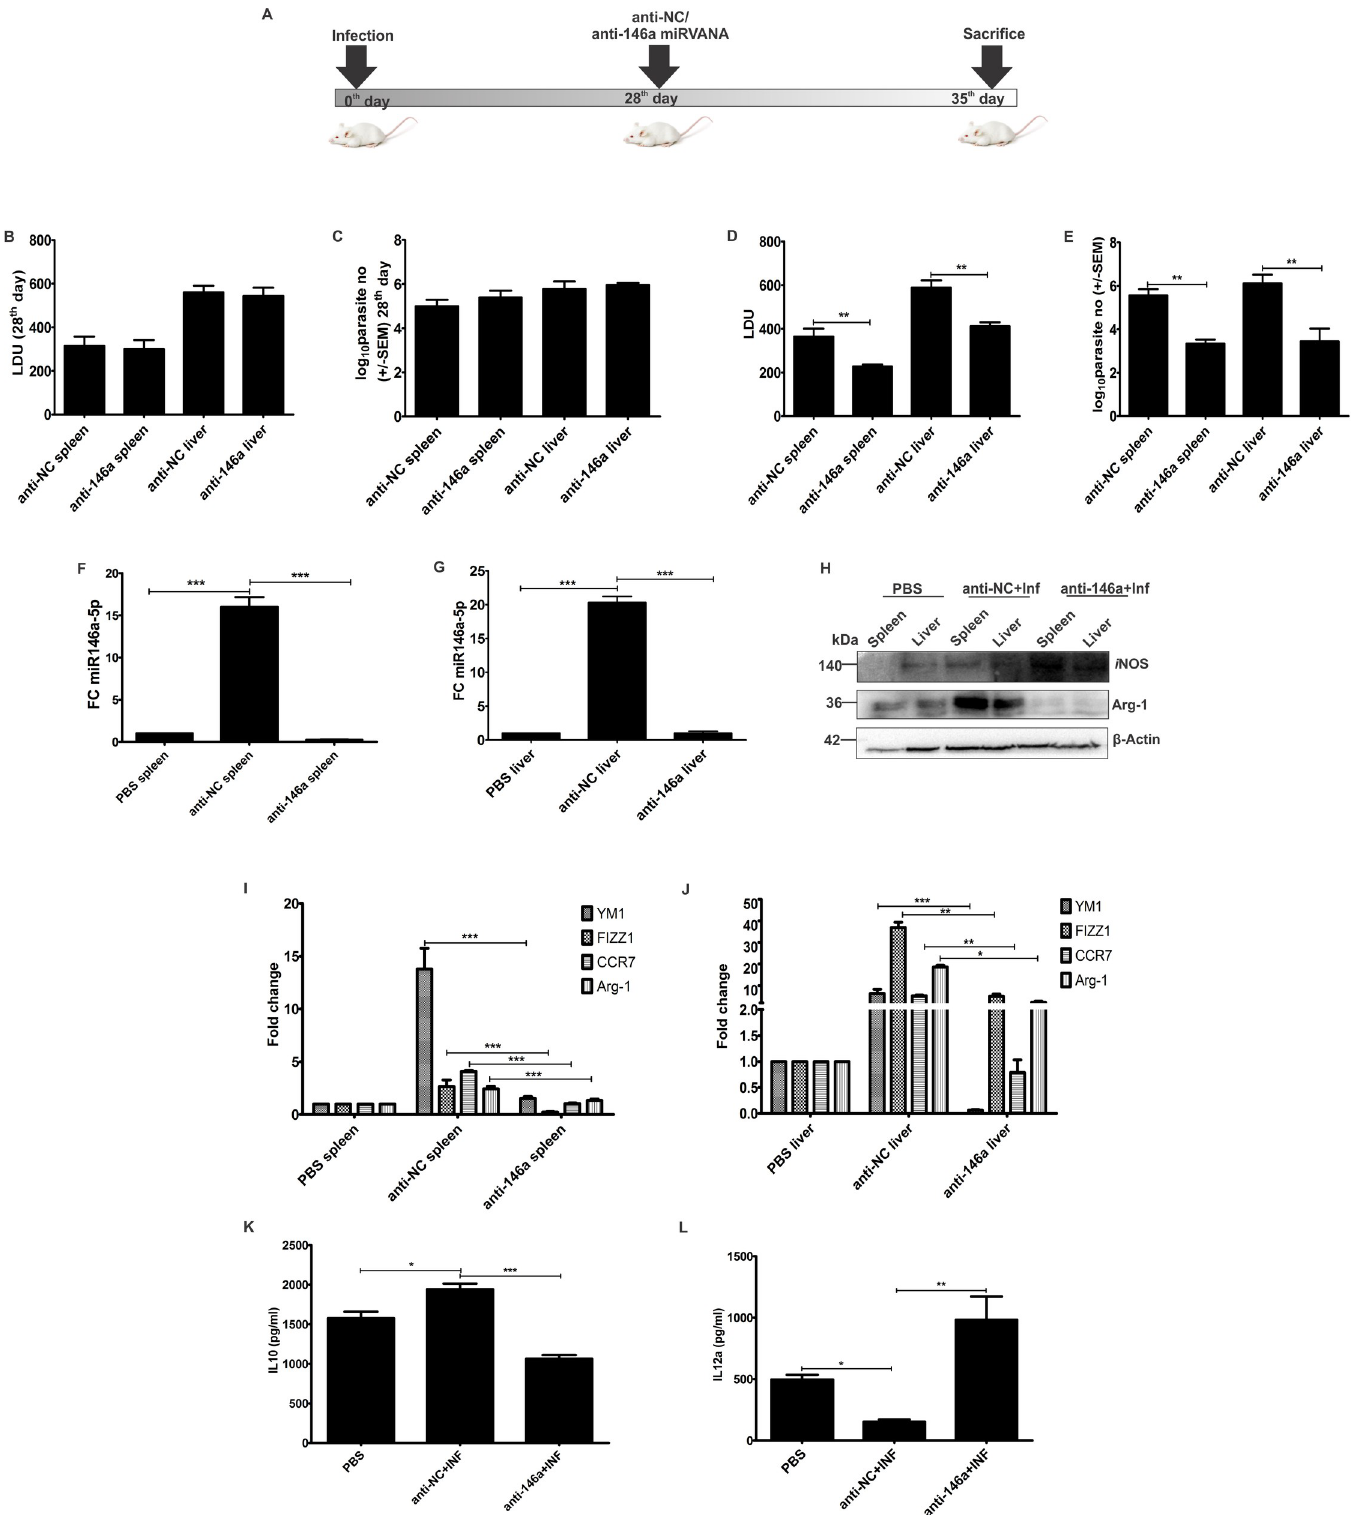
Fig 7. Parasite burden and M2 polarity markers got abrogated in miR146a inhibited BALB/c mice organs. (A) 4–6 weeks old BALB/c mice were infected with 2X10 7 L . donovani suspended in 1.8% glucose- phosphate buffered saline solution. Before administration of anti-NC and ant-146a oligos, 28-days post-infection, infection